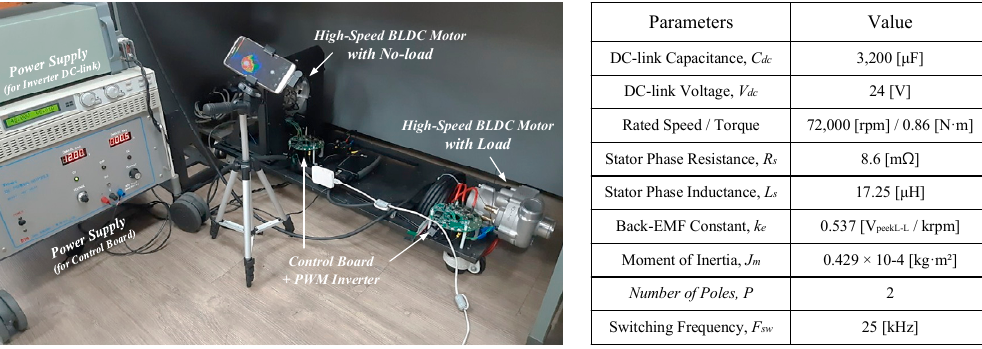
Figure 8. Experimental setup and electrical parameters.